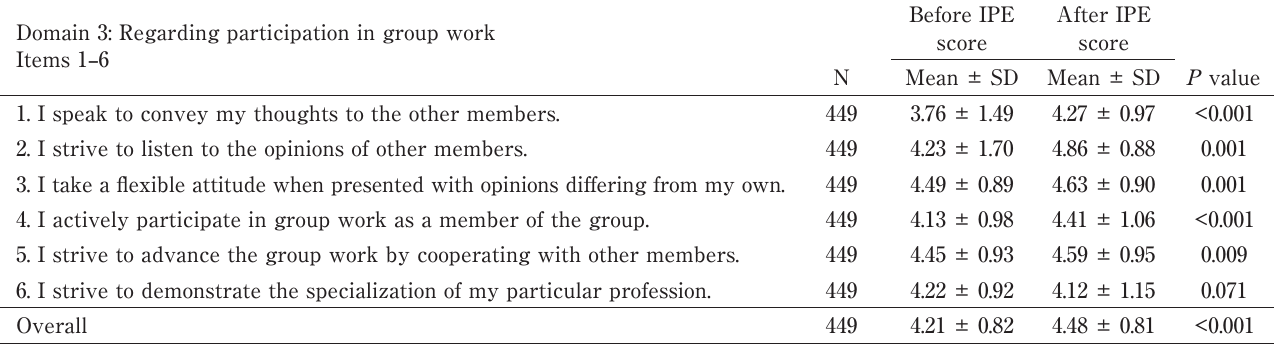
Table 4. Comparison of the scores before and after IPE in domain 3